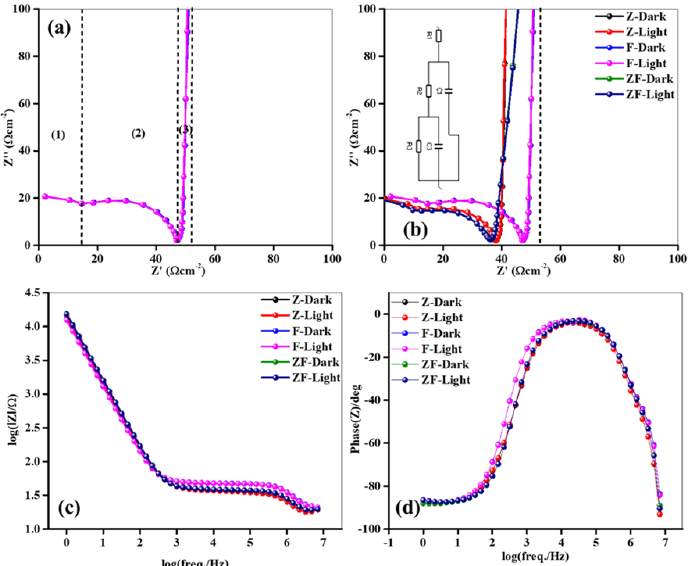
Figure 6. ( a ) Nyquist plots with general specified regions, ( b ) Nyquist plots of ZnFe 2 O 4 (Z), Fe 2 O 3 (F), and ZnFe 2 O 4 -Fe 2 O 3 (ZF) nanostructures under light ON/OFF states in 0.1 M KOH electrolyte, ( c ) bode plots of ZnFe 2 O 4 (Z), Fe 2 O 3 (F), and ZnFe 2 O 4 -Fe 2 O 3 (ZF) nanostructures under light ON/OFF states in 0.1 M KOH electrolyte, and ( d ) phase plots of ZnFe 2 O 4 (Z), Fe 2 O 3 (F), and ZnFe 2 O 4 -Fe 2 O 3 (ZF) nanostructures under light ON/OFF states in 0.1 M KOH electrolyte. Table 1. Equivalent circuit fitted values of synthesized samples in 0.1 M KOH electrolyte under dark/light state.